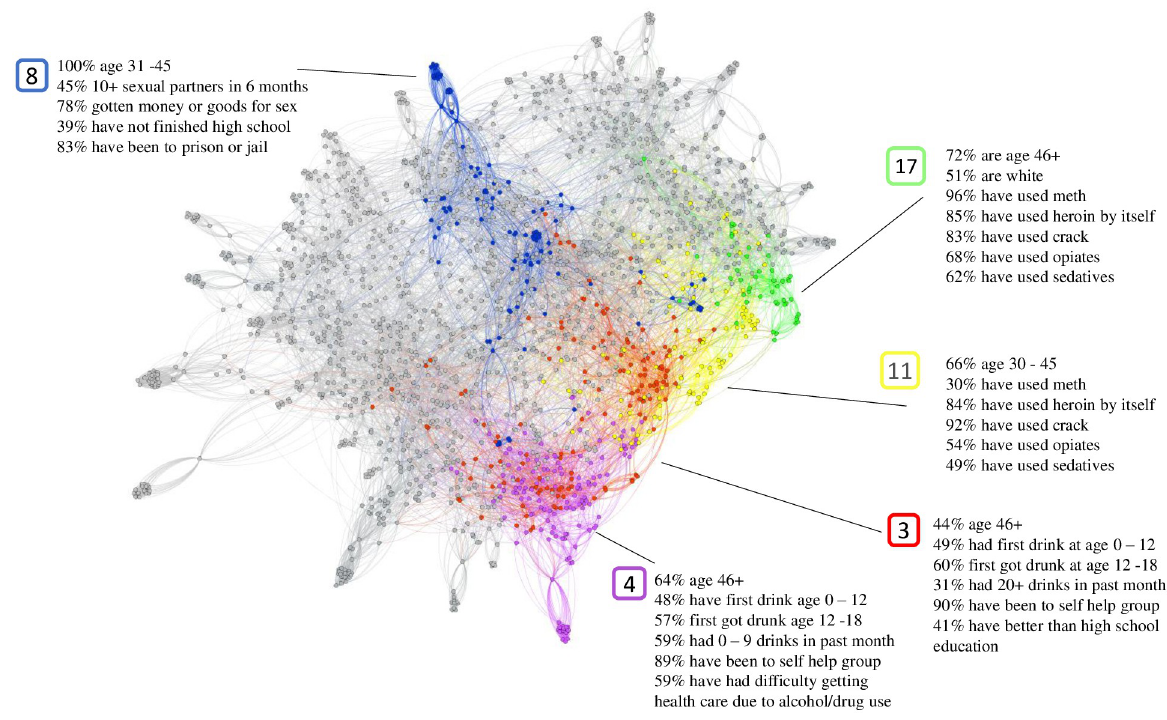
Fig 4. Homelessness